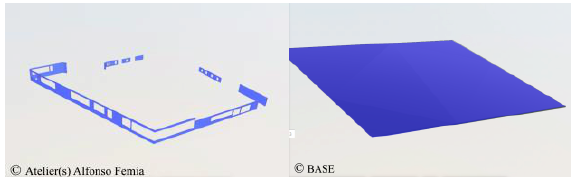
Figure 3 . Street front (left) and breaking space